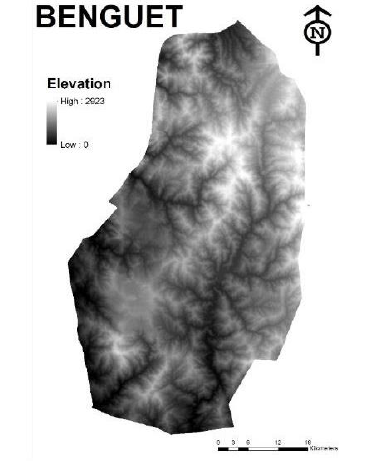
Figure 1. Elevation Map of